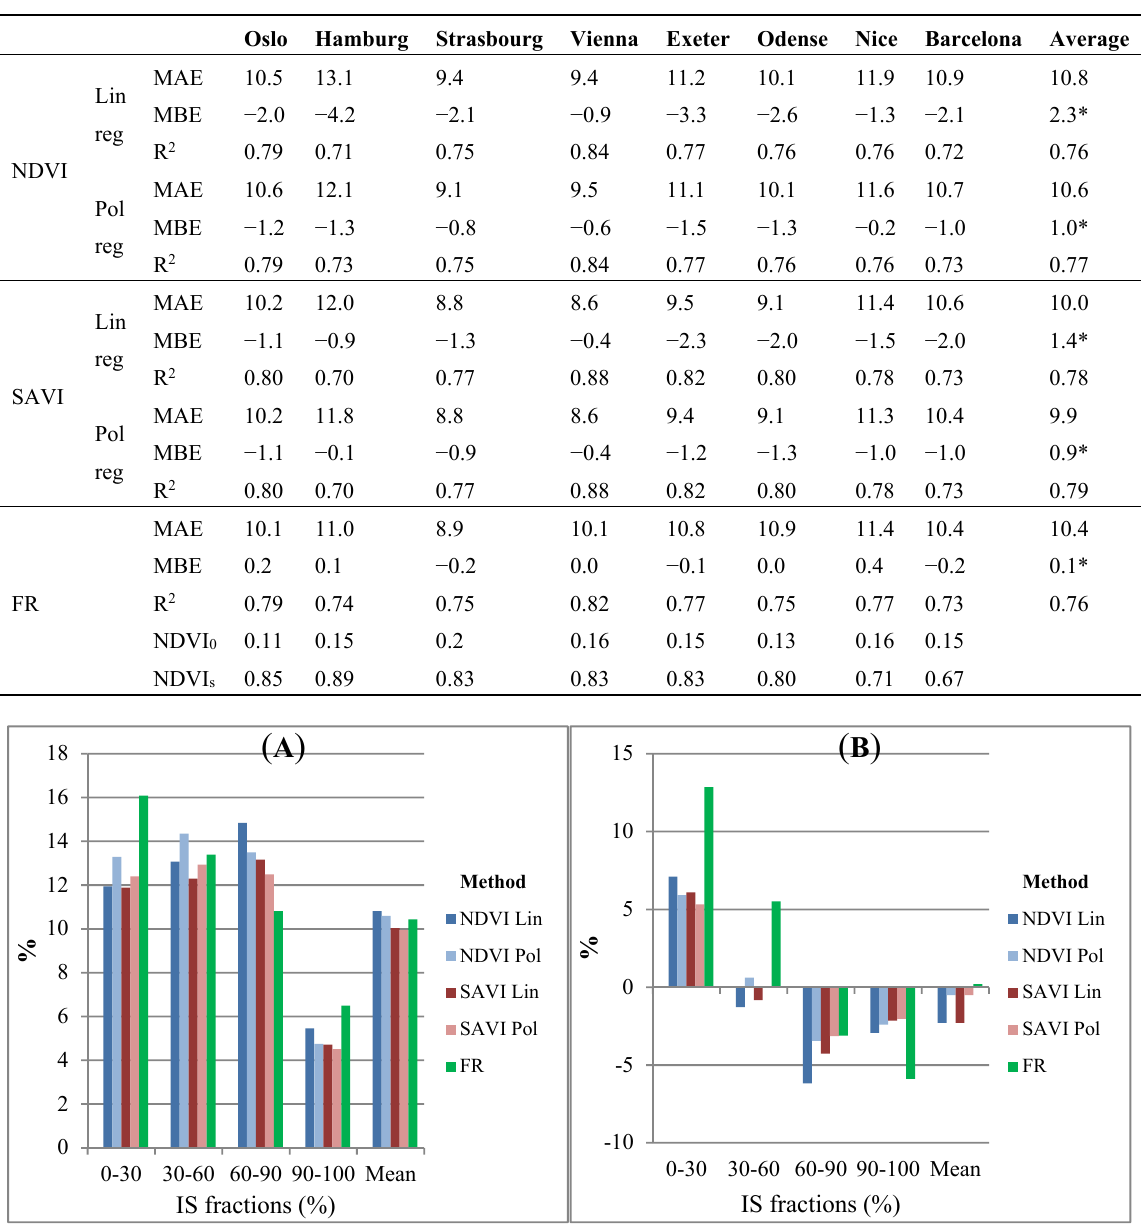
Table 4. MAEs, MBEs and R 2 for IS estimates based on NDVI/SAVI and FR as compared to reference IS fractions, Lin reg = Linear regression model, Pol reg = Second order polynomial regression model, * absolute mean.